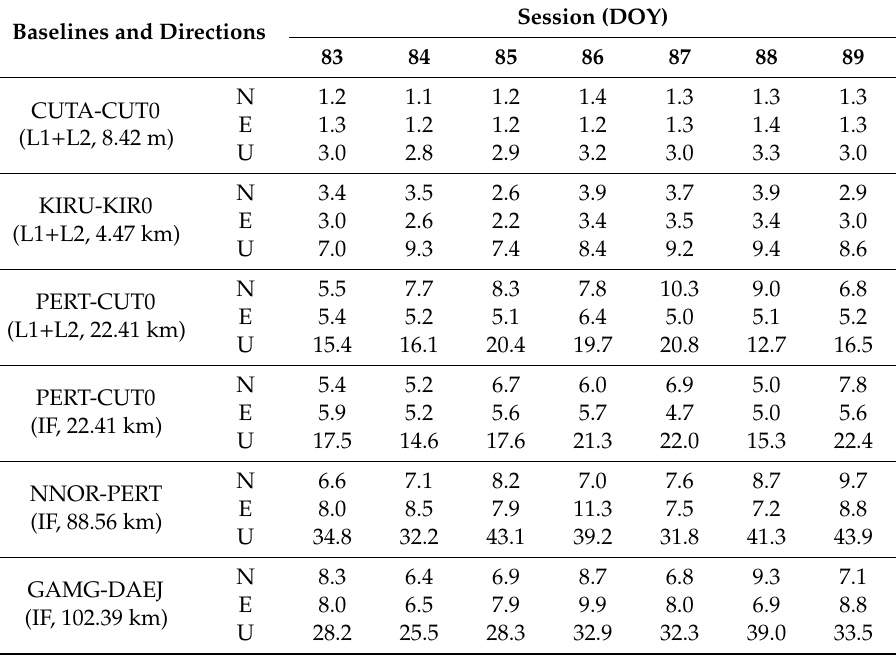
Table 4. RMS statistics of the baselines resolutions compared with GAMIT solutions (mm).